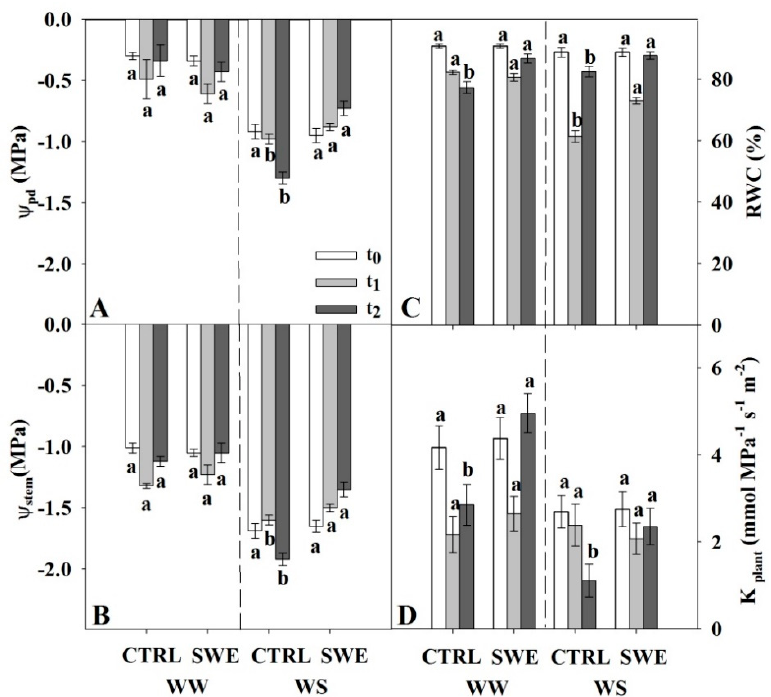
Figure 2. ( A ) Predawn ( Ψ pd ) and ( B ) midday stem ( Ψ stem ) water potentials, ( C ) relative water content (RWC), and ( D ) plant hydraulic conductivity (K plant ) in V. vinifera treated with A. nodosum extract (SWE) and untreated plants (CTRL), under two irrigation regimes (WW, well-watered; WS, water stressed). Means (±SE, n = 10) followed by distinct letters within the same water regime and sampling time are significantly different according to the LSD test ( p ≤ 0.05). Measurements were conducted at t 0 (white bar), t 1 (grey bar), and t 2 (dark grey bar) Table 2. Two-way ANOVA ( p < 0.05) for eco-physiology, chemical features of the berry and productivity parameters in V. vinifera treated with A. nodosum extract (SWE) and untreated plants (CTRL), under two irrigation regimes (WW, well-watered; WS, water stressed).